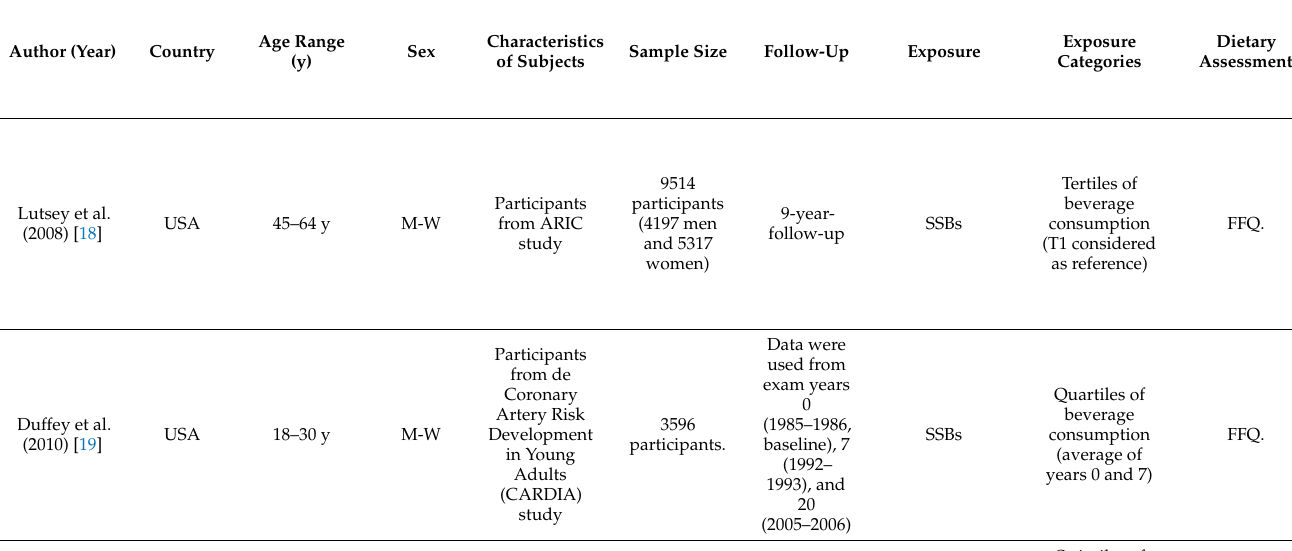
Table 3. Characteristics of the cohort studies sorted by inclusion status and chronological year of